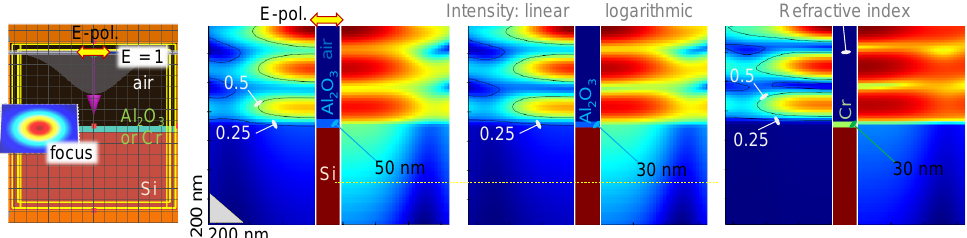
Figure 2. Numerical modelling of light focused onto a 700 nm diameter on the sample surface for a λ = 515 nm wavelength. Linear E and lg E distributions are shown; the incident light E-field is E = 1. Contours for E = 0.5 and E = 0.25 are shown. The central cross-section shows the refractive index distribution across the light propagation. The left panel shows the calculation volume in the finite difference time domain (FDTD) model (Lumerical, Ansys).